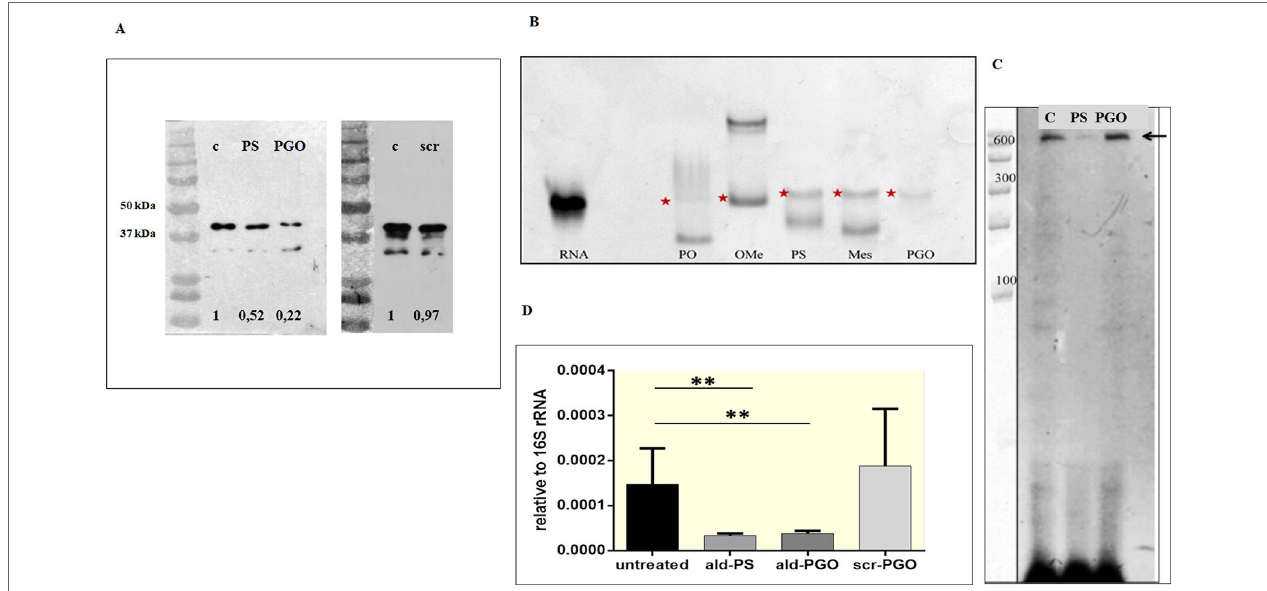
FIGURE 3 | 2 ′ -OMe PGO inhibits the expression of the target gene in Mycobacterium smegmatis . (A) Specific inhibition of protein synthesis by antisense ald -PGO. M. smegmatis cultures were treated with 20 μM of ald -PGO (PGO), ald -PS (PS), and scr-PGO (scr) or left untreated (control, C) for 24 h and analyzed for Ald protein expression by western blotting; numbers below indicate the ratio to control. (B) Cleavage of ASO : RNA duplexes by RNase H. Target RNA duplexes with ald (PO), ald -oligo-2 ′ - O -methylribonucleotide (OMe), ald -PS (PS), μ- ald (Mes), and ald -PGO (PGO) were treated by RNAse H and analyzed by PAGE in a denaturing 15% gel, which was stained with SYBR Green. Red asterisks indicate RNA. (C) Primer extension analysis of the ald gene transcription. RNA was isolated from M. smegmatis cultures treated with 20 μM of ald -PGO (PGO) and ald -PS (PS) or left untreated (control, C) for 24 h and reverse transcribed using a radioactively labeled ald -specific oligonucleotide. The arrow indicates the transcription start point. RiboRuler RNA ladder (Thermo Fisher Scientific) is shown at the left. (D) Quantification of ald transcription. M. smegmatis cultures were treated with 20 μM of the indicated ASOs for 24 h and analyzed for ald mRNA expression by qRT-PCR. The data are normalized to the 16S rRNA transcription level. ** p < 0.01. 2 ′ -OMe PGO, phosphoryl guanidine oligo-2 ′ - O -methylribonucleotide; PAGE, polyacrylamide